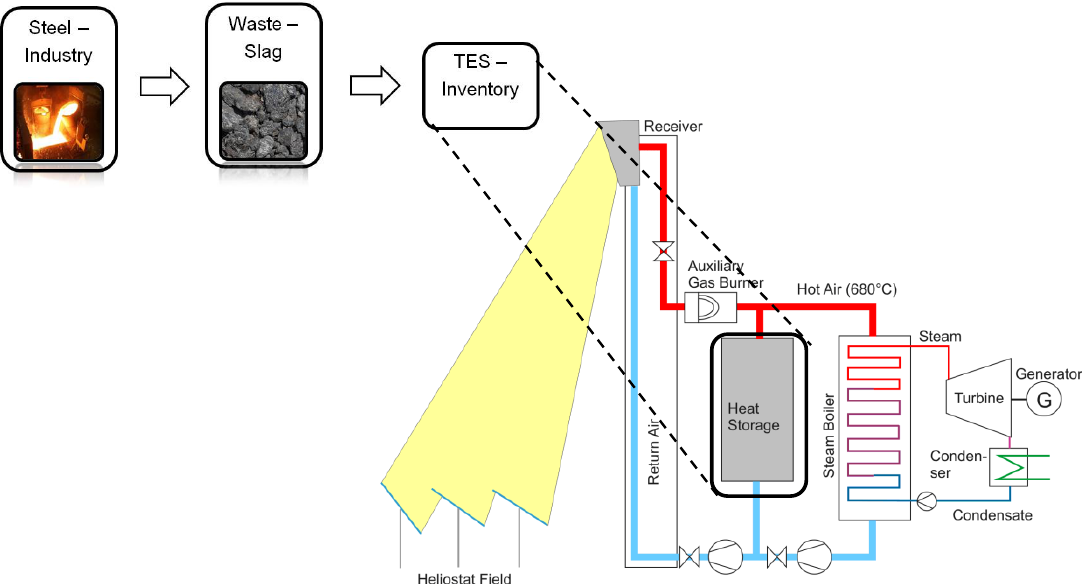
Figure 1. Flowsheet of slag reuse as a thermal energy storage (TES) inventory for a concentrated solar power (CSP) plant with an open volumetric receiver.